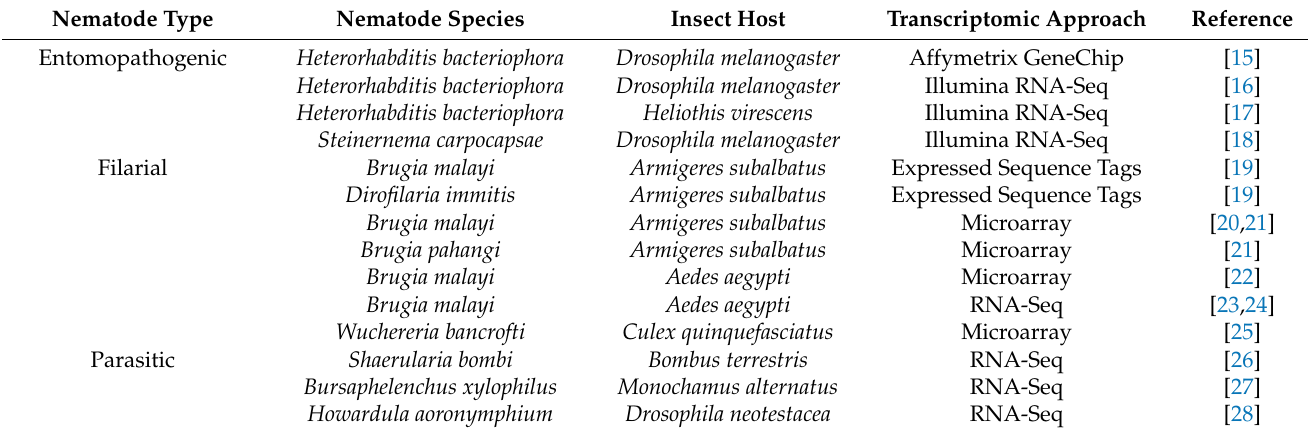
Table 1. Nematodes, their insect hosts, and transcriptomic approaches included in this review. Nematode